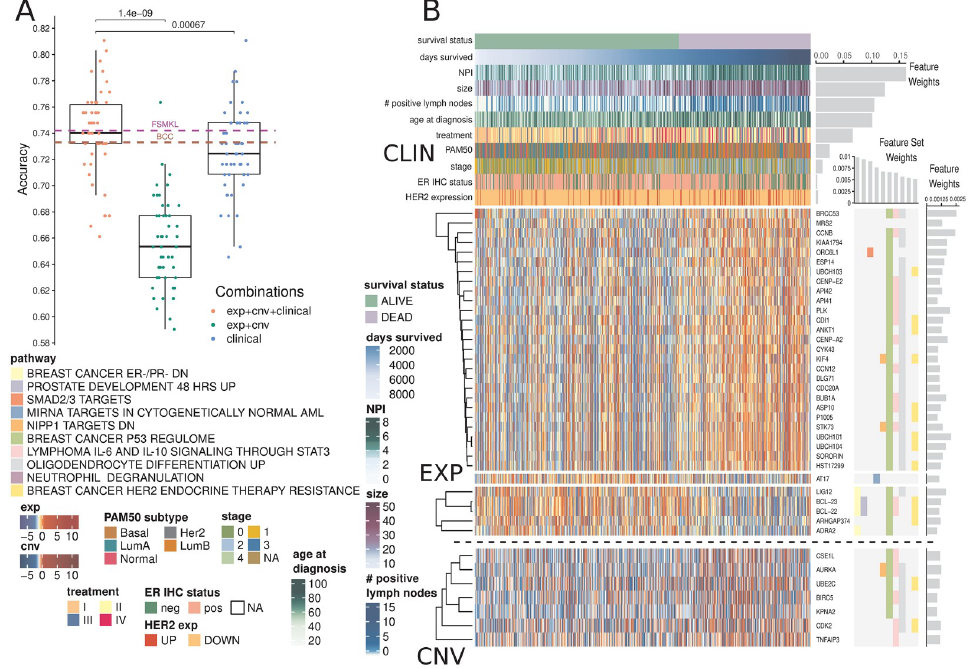
Fig 2. AKLIMATE performance on predicting survival at 2000 days in the METABRIC cohort. (A) Performance of AKLIMATE under different data type combinations. EXP+CNV—AKLIMATE with genomic features only; clinical—an RF model run with the clinical variables only; EXP+CNV+CLINICAL—AKLIMATE with genomic features as “local” variables and clinical features as “global” ones. FSMKL and BCC dashed lines show mean performances for the two models under 5-fold cross-validation as shown in [16]. (B) AKLIMATE results highlighting the top 10 predictive feature sets and top 50 predictive features. Figure organized as Fig 1. Clinical variables shown as column annotations; included only if among the 50 most informative features in the model. Clinical variables are ranked from top to bottom by relative predictive contribution. Survival status is a binary variable representing survival at 2000 days (labels) while days survived shows actual duration of survival. Samples sorted by days survived within the two classes. Feature and feature set weights averaged across 50 train/test splits.